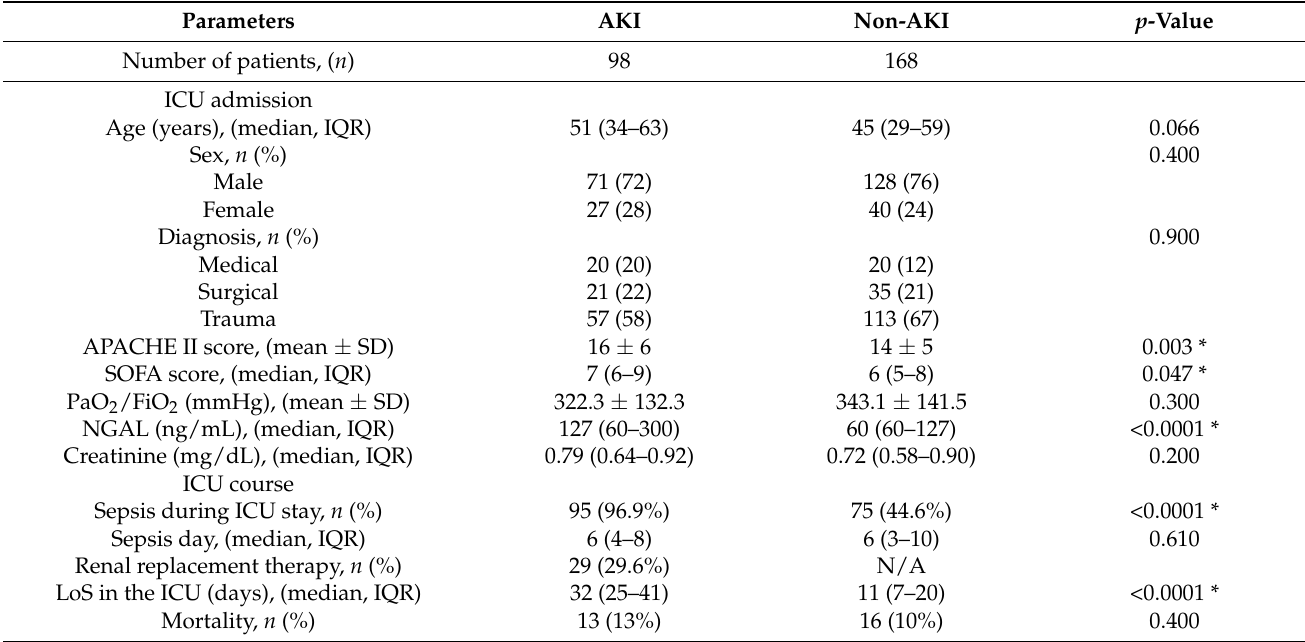
Figure 1. Flowchart of the study’s enrollment. Definition of abbreviations: AKI = Acute kidney injury; BMI = Body mass index; ICU = Intensive care unit. Table 1. Demographics, clinical and laboratory characteristics of the two patient groups at ICU admission, and important